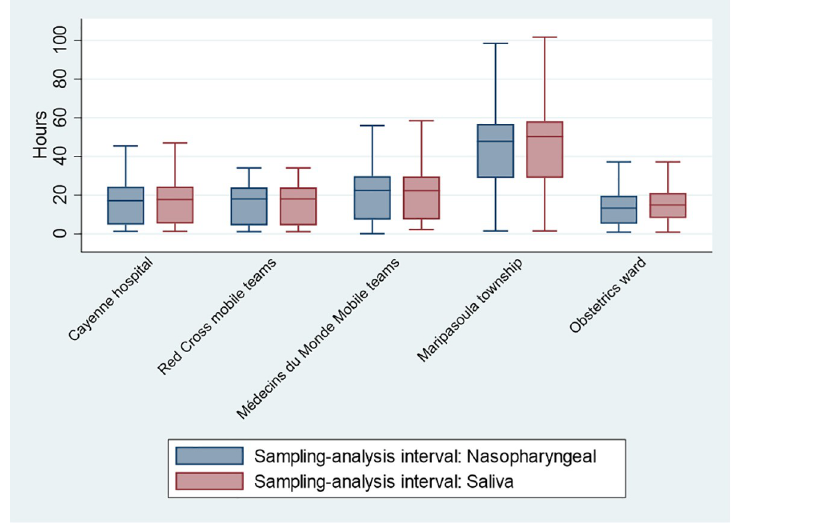
Fig 2. Interval between sample collection and